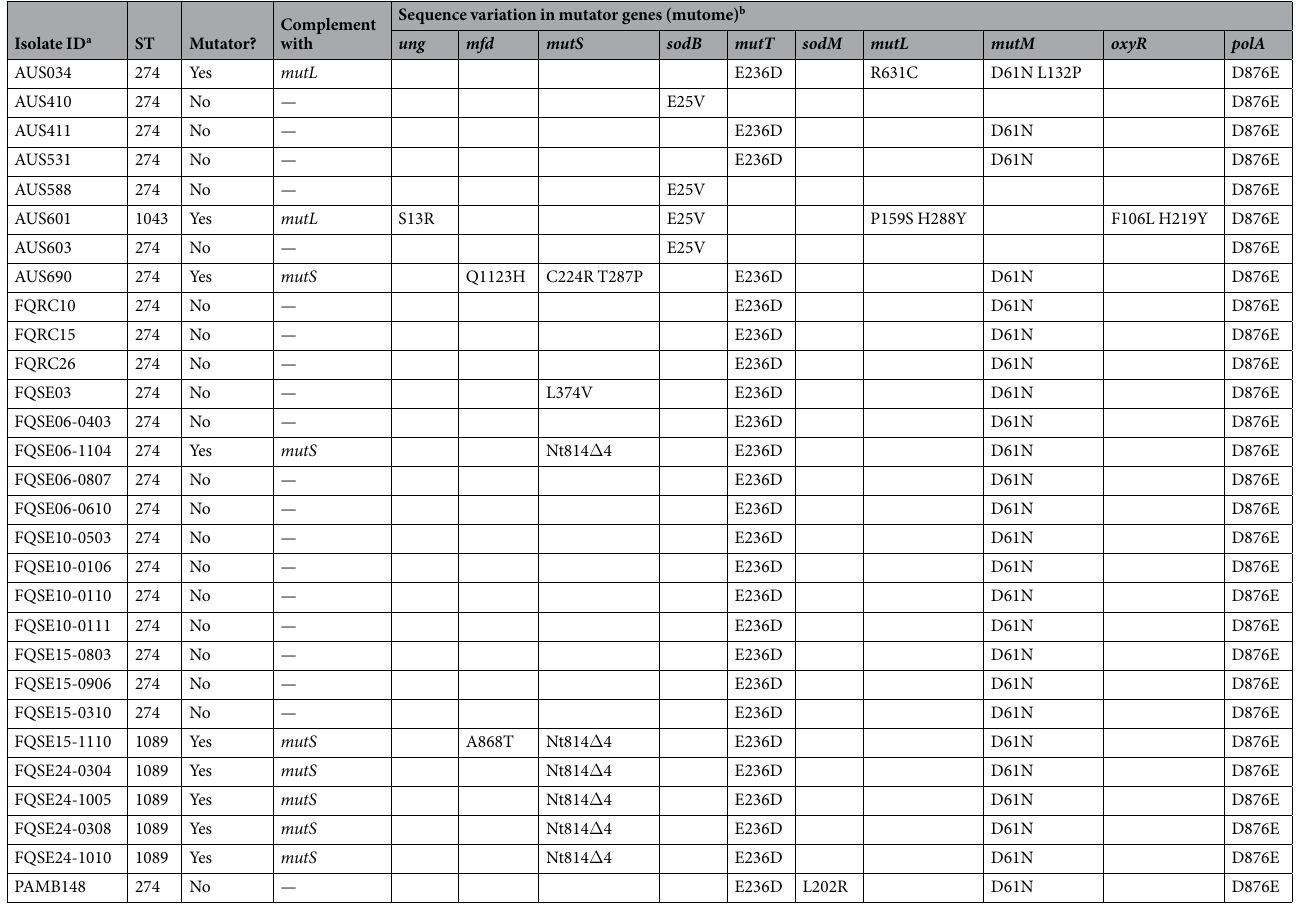
Table 1. Mutator phenotype and genetic basis of hypermutation in CC274. a Isolates are labelled according to the following format: Patient identification - MMYY isolation code in the case of sequential isolates. b Sequence variations respect to those of PAO1. No mutations were found in other genes associated with